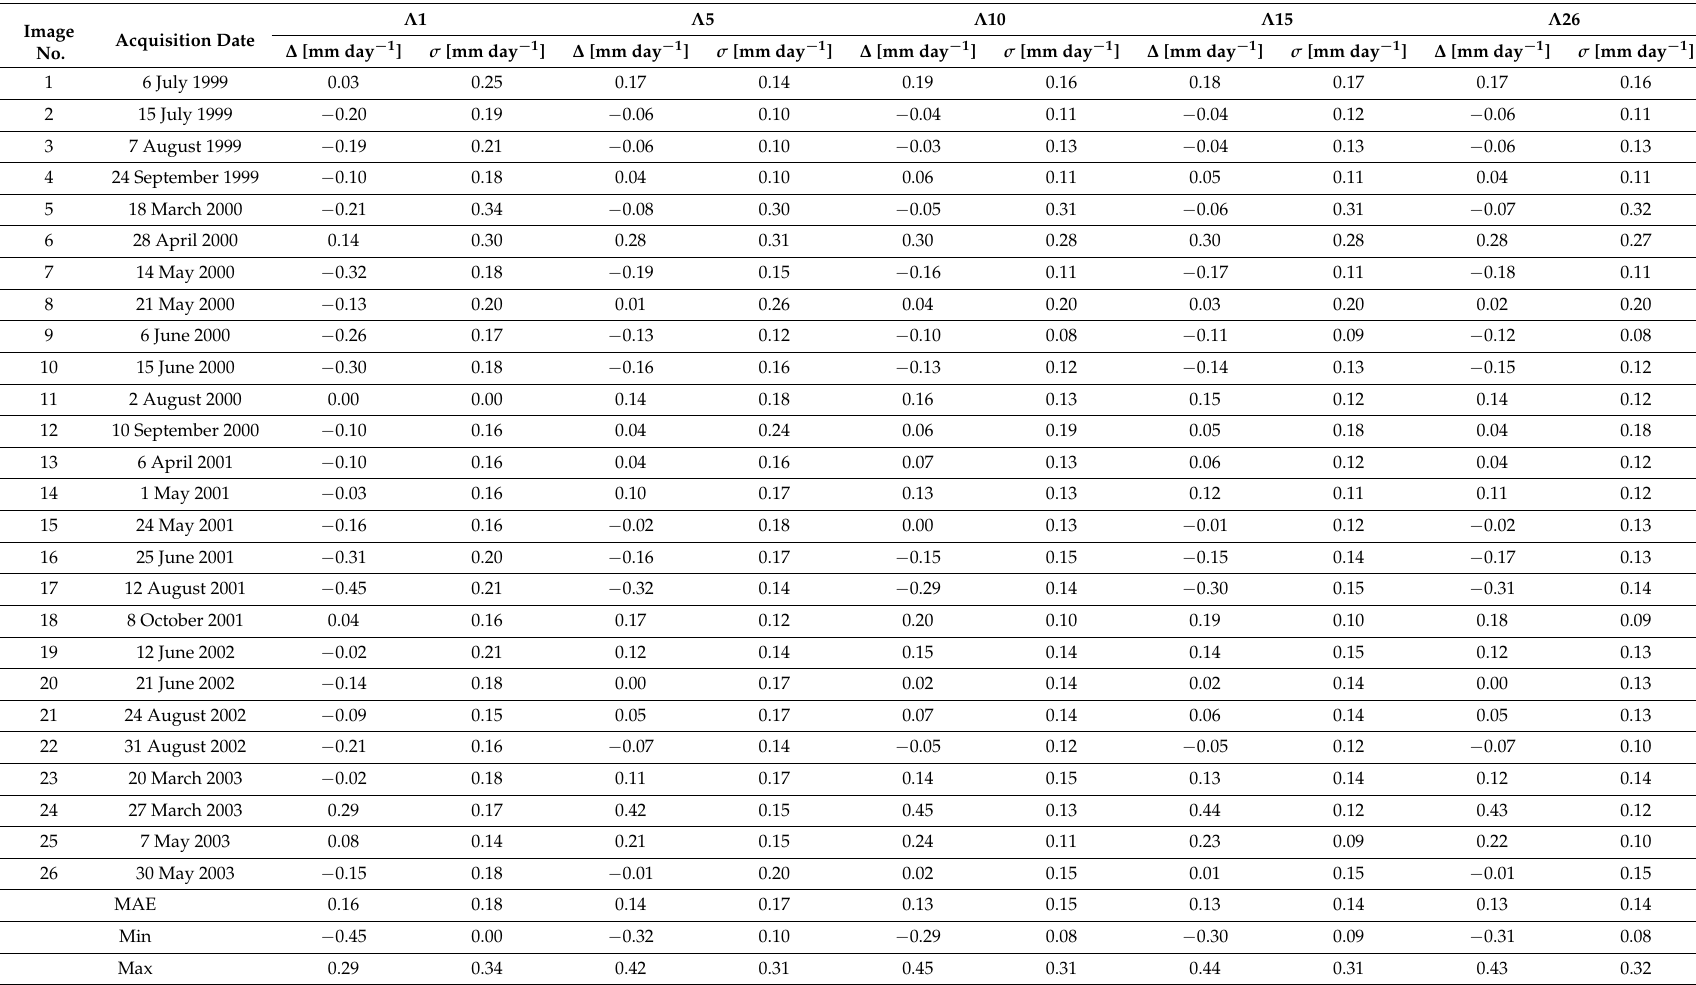
Table 1. Validation of Λ INT depending on the number of Λ used for interpolation. MAE: Mean absolute errors. Image